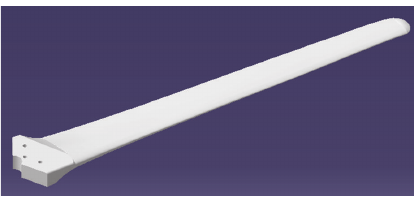
Figure 4: Model of a standard blade.